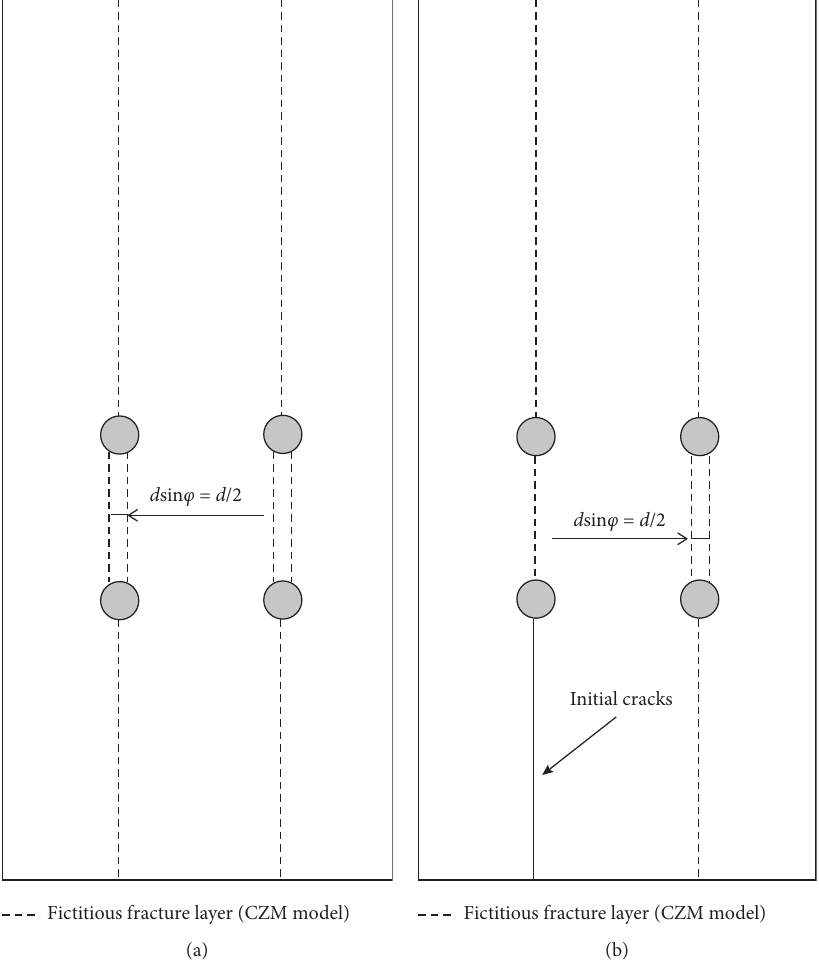
Figure 5: Fictitious fracture layers set in joints with four bolts. (a) Without initial cracks. (b) With initial cracks.